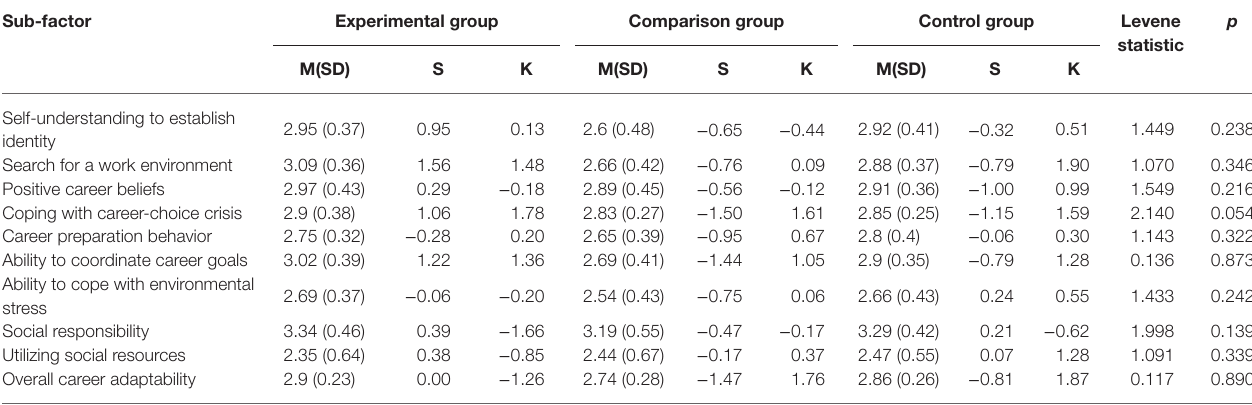
TABLE 4 | Descriptive statistics by group.